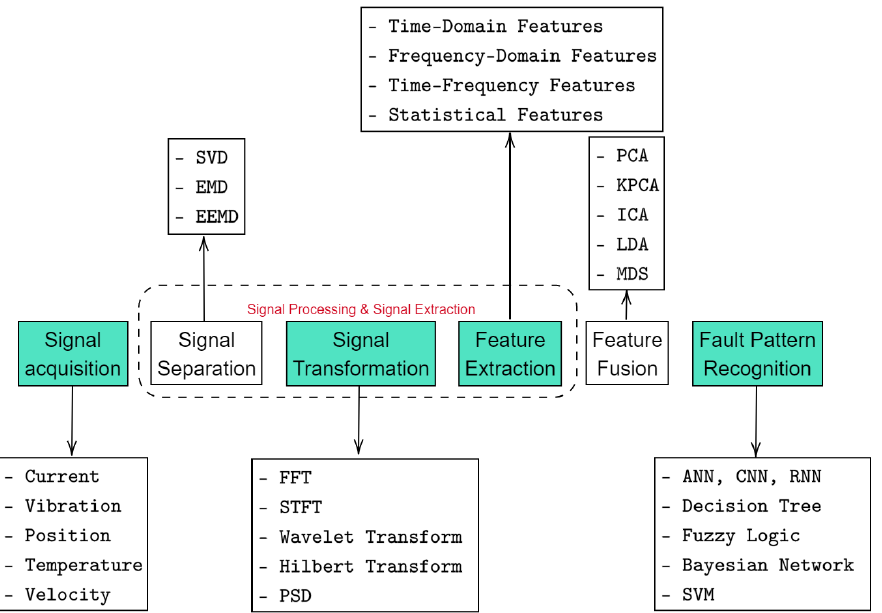
Figure 5. Process of fault diagnosis based on signals. The basic tasks of this process are signal acquisition, signal transformation, feature extraction and fault pattern recognition.